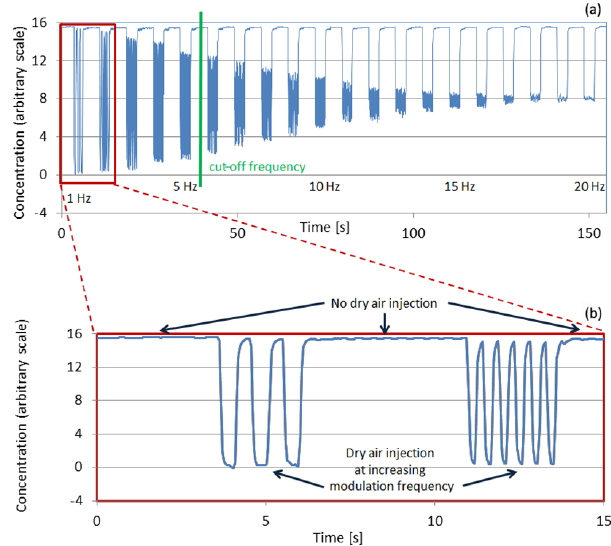
Figure 2. Recording of concentration measurements by the IRGA during one measurement cycle. (a) Representation of the whole cy- cle. The frequencies given in the figure are the concentration mod- ulation frequencies. (b) Focus on the first 15s. For details, see